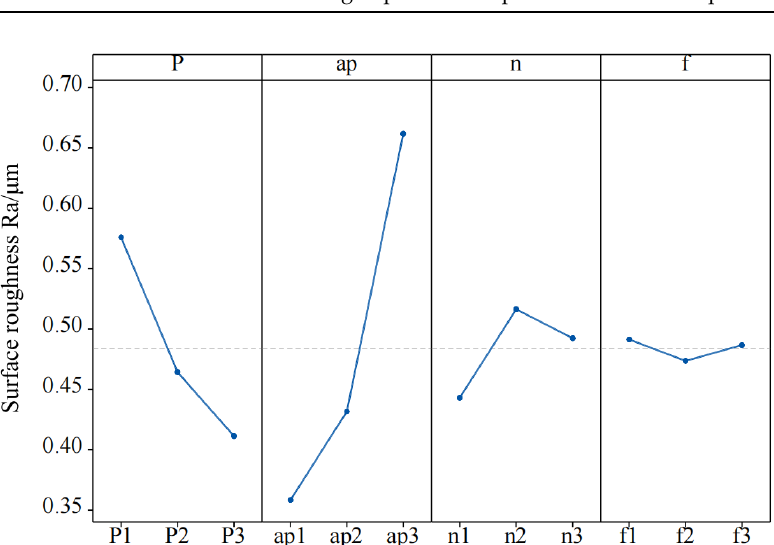
Figure 3 shows the plot of the mean effect of each factor level with surface roughness obtained based on the results of the range analysis, and the variation trend of surface roughness can be directly reflected in the level range of each factor. The optimization level combination was determined by analyzing the variation trend of surface roughness in Figure 3. The specific optimization parameters were: laser power 240 W, cutting depth 0.1 mm, rotational speed 1500 r/min, feed speed 3 mm/min. Using this optimized combina- tion of parameters for cutting SiC ceramics, the surface roughness Ra value of 0.315 μm was obtained, which is lower than that of 0.321 μm in experiment No. 8 of the orthogonal scheme.